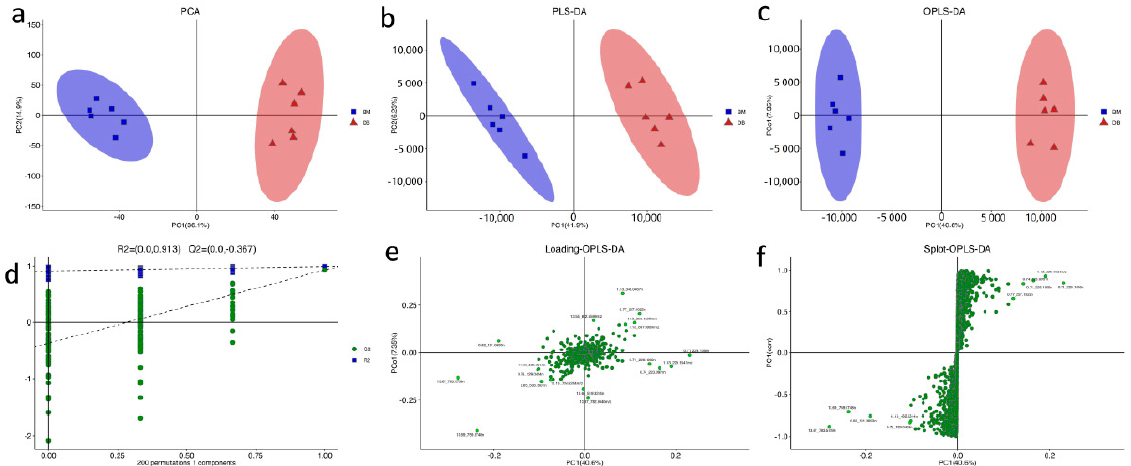
Figure 1. Statistical analysis of metabolites between BM and DB. Principal component analysis (PCA) results ( a ) PLS-DA analysis result ( b ) OPLA-DA analysis result ( c ) showed that the clustering of each group is strong, with little difference within the group, but the difference between groups is obvious. All of these models were evaluated using parameter R2X (cum) ( d ). We used the Loading OPLA-DA to find the most important metabolic ions close to − 1 and 1 ( e ). We used the Splot-OPLS- DA to screen the metabolites closer to the two corners ( f ). BM: Bama xiang pig; DB: Debao pig.